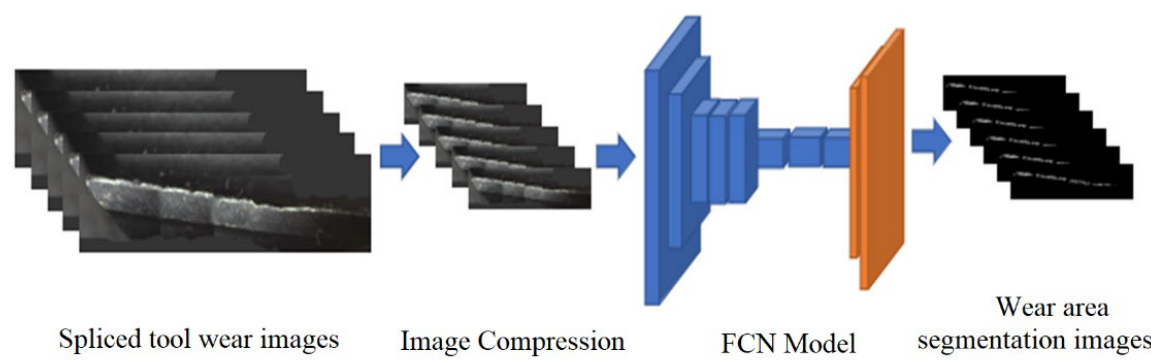
Figure 6. Schematic diagram of the structure of the segmentation algorithm.